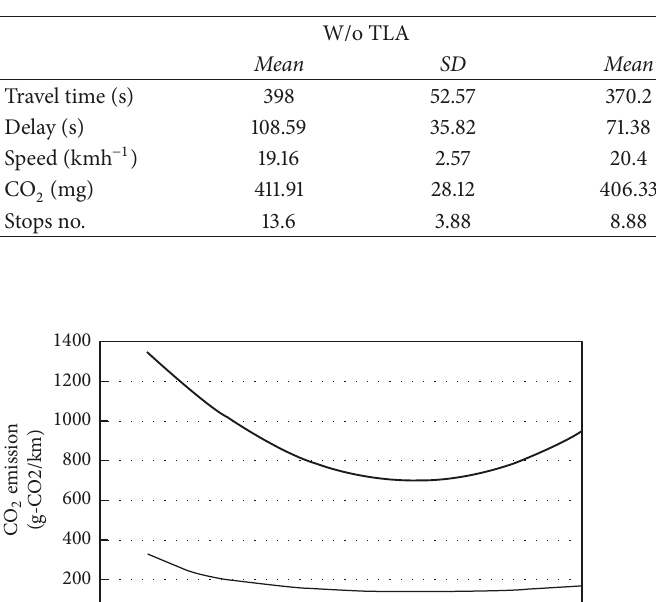
Table 1: Driving performance depending on the activation of the TLA.